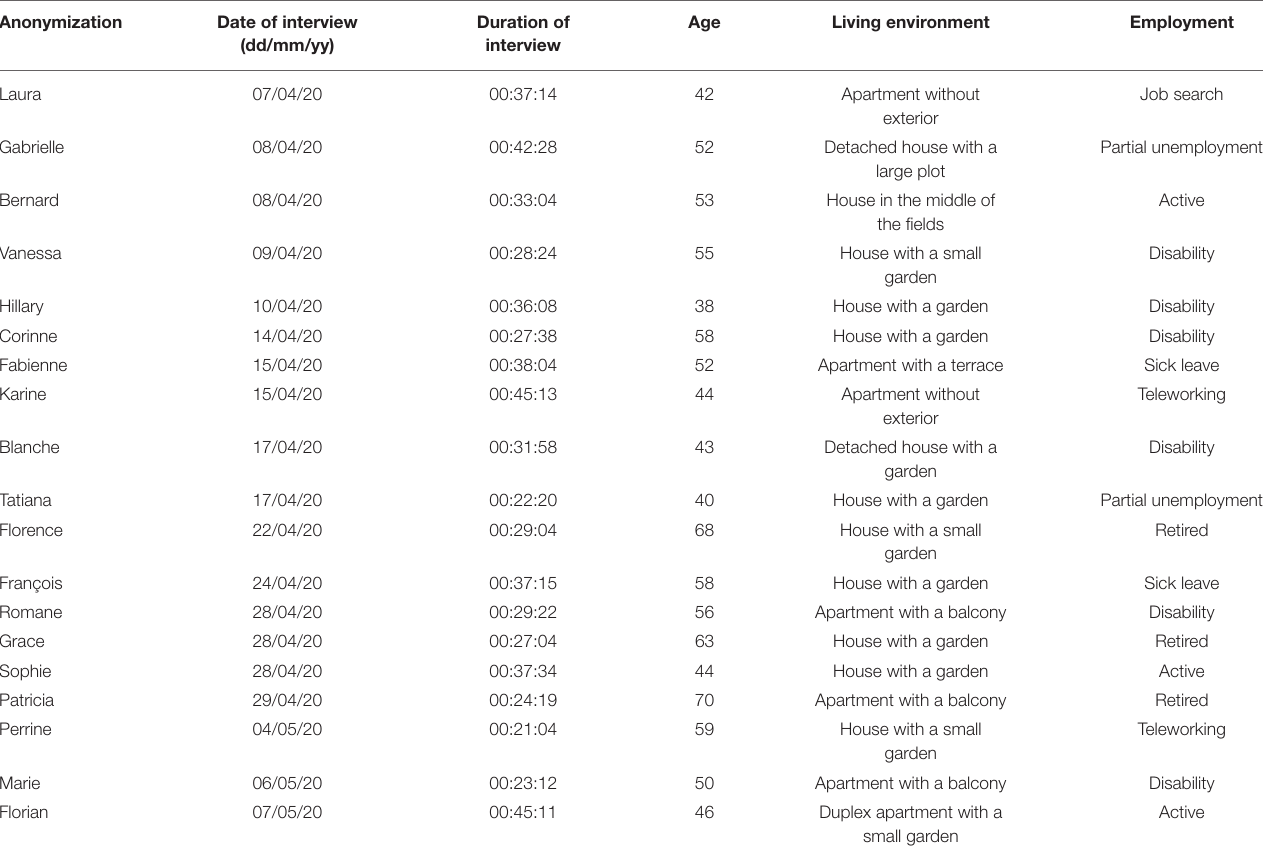
TABLE 1 | Characteristics of